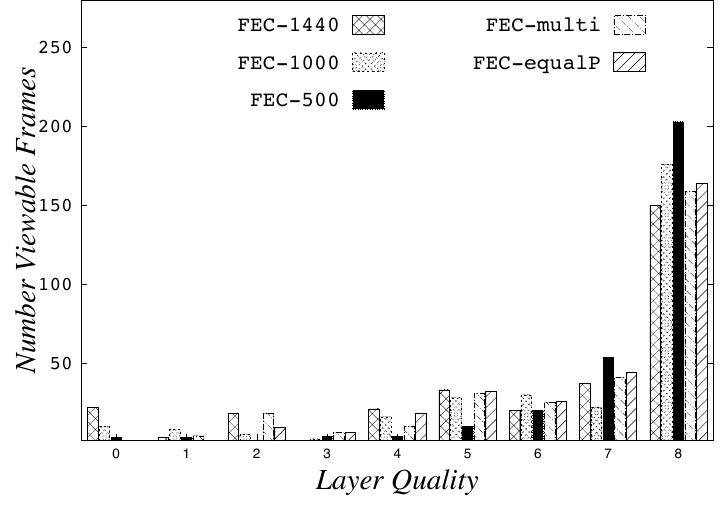
Figure A7. Example of the number of viewable layers for SVC-SC, for each of the FECPacket thres , at a packet loss rate of 10%. This image illustrates an increase in the FEC for C1 and C2 based on the worst case scenario, as shown in Table A2.